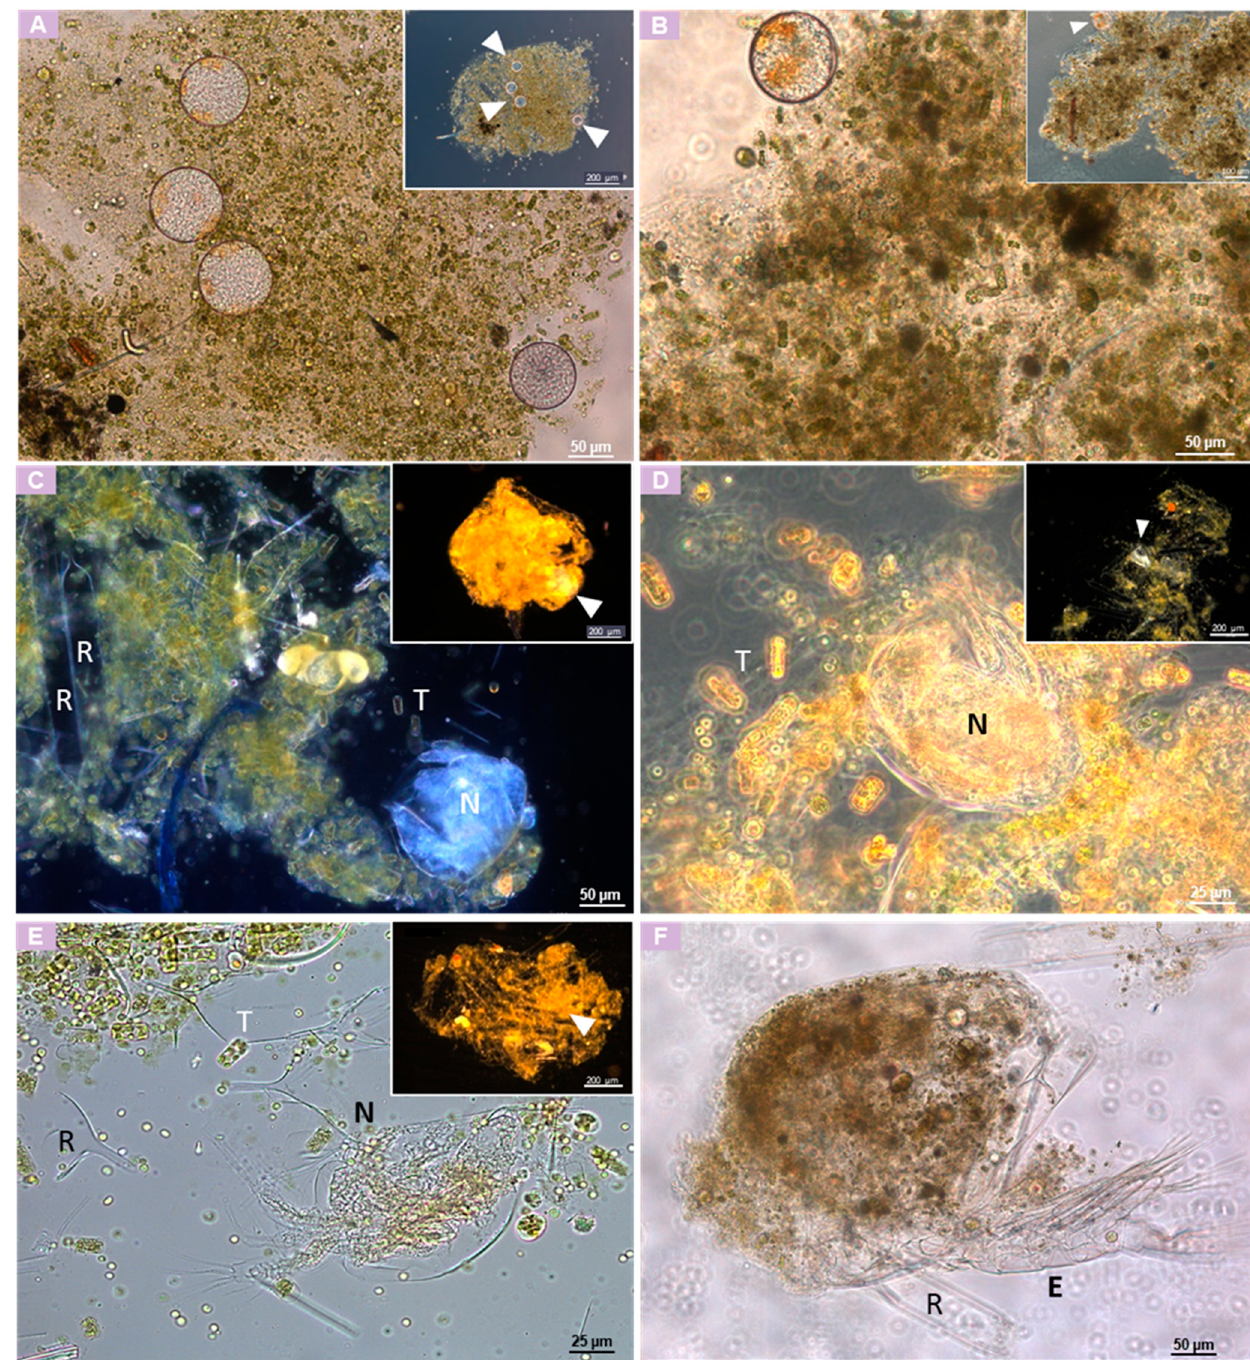
Figure 2. Light microscope photographs of fecal pellets of Dolioletta gegenbauri containing intact eggs ( A , B ) and juvenile stages ( C – E ) of the small calanoid copepod Paracalanus quasimodo. The inserts show the intact doliolid pellets. The white arrows indicate the hardly recognizable ingested zooplankton food items (eggs, nauplii, and copepodids of P. quasimodo ) that were only detectable after the pellets were smashed (see food items at larger magnifications). ( A , B ) Phase-contrast micrographs of doliolid fecal pellets containing four and one P. quasimodo eggs with diameters ranging from 60 to 65 μ m. ( C – E ) Dark-field and phase-contrast micrographs of smashed doliolid fecal pellets showing their nauplii (N) “unwrapped”. ( F ) Phase-contrast micrograph of a doliolid fecal pellet containing a several hundred micron long exuvia of a copepodid of P. quasimodo . T = intact digested cells of Thalassiosira weissflogii; R = empty cells of Rhizosolenia alata. E = exuvia.